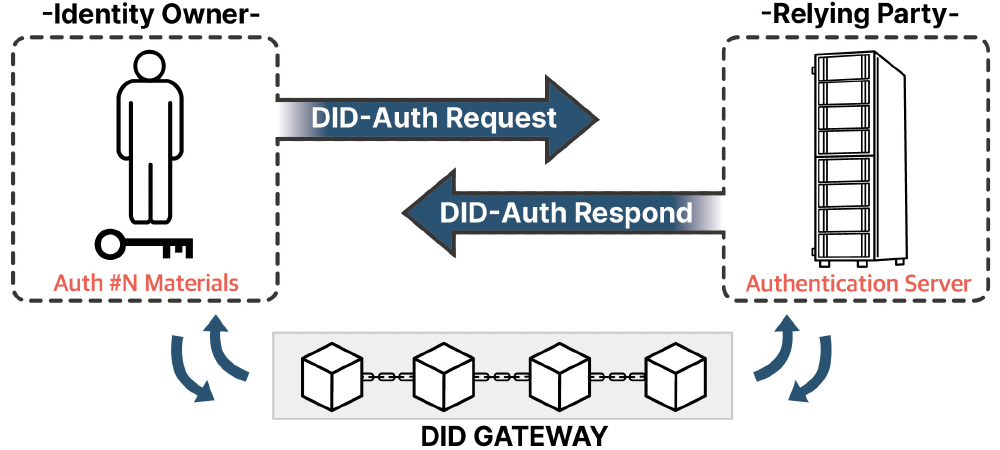
Figure 4. Details of the DID authentication network.